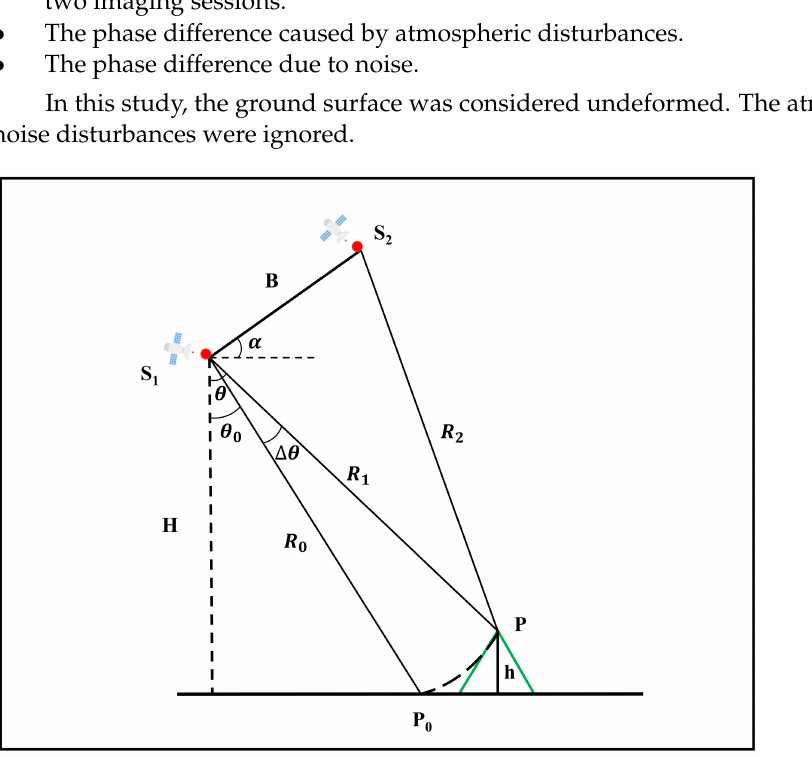
Figure 7. Schematic illustration of Interferometric